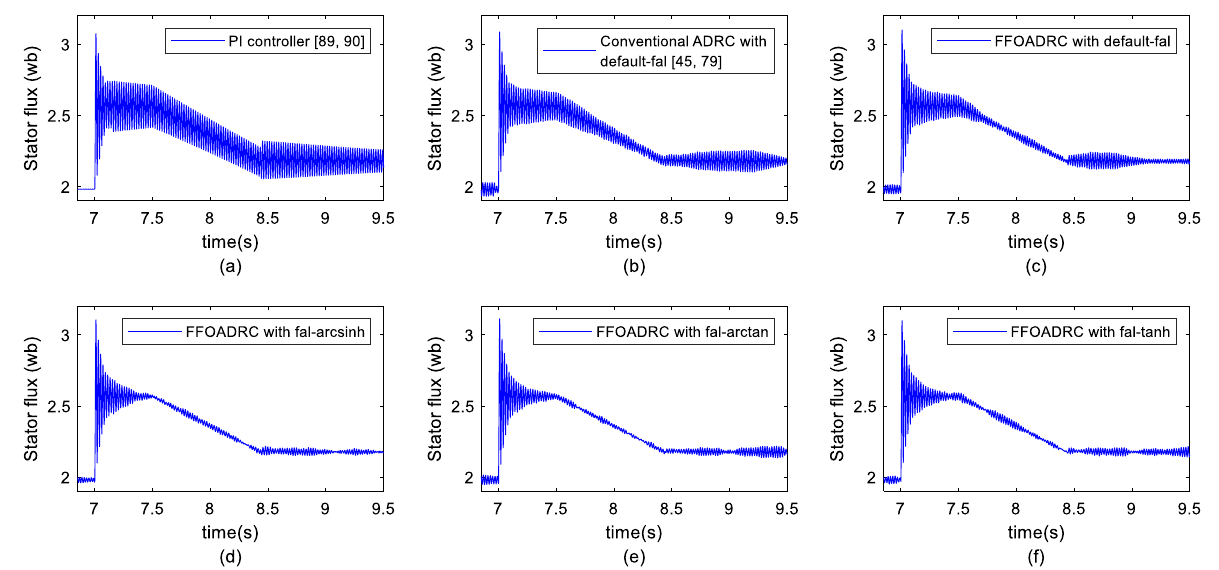
Fig. 26 Stator flux of the DFIG during symmetrical voltage swell: ( a ) PI controller [89, 90], ( b ) Conventional ADRC with default-fal [45, 79], ( c ) FFOADRC with default-fal, ( d ) FFOADRC with fal-arcsinh, ( e ) FFOADRC with fal-arctan, and ( f ) FFOADRC with fal-tanh